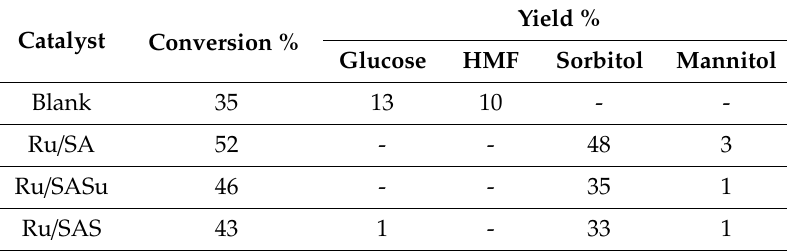
Figure 6. Scheme of the reactions and products considered in the present work. Table 4. Cellulose conversion and products yield.